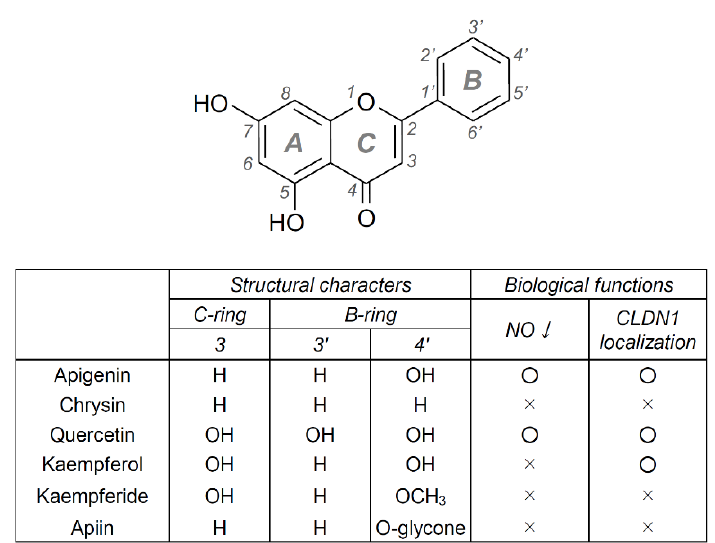
Figure 9. Structural characters and biological function of apigenin-like flavonoids. Representative chemical structure of 5,7-dihydroxylated flavonoid is shown above. The groups at each position on the B- or C-ring in the flavonoid are presented. H, hydrogen; OH, hydroxyl group; OCH 3 , methoxy group; O-glycone, glycosyl substitution of the hydroxy group. The effects of apigenin and apigenin-like flavonoids are summarized in the biological functions column.